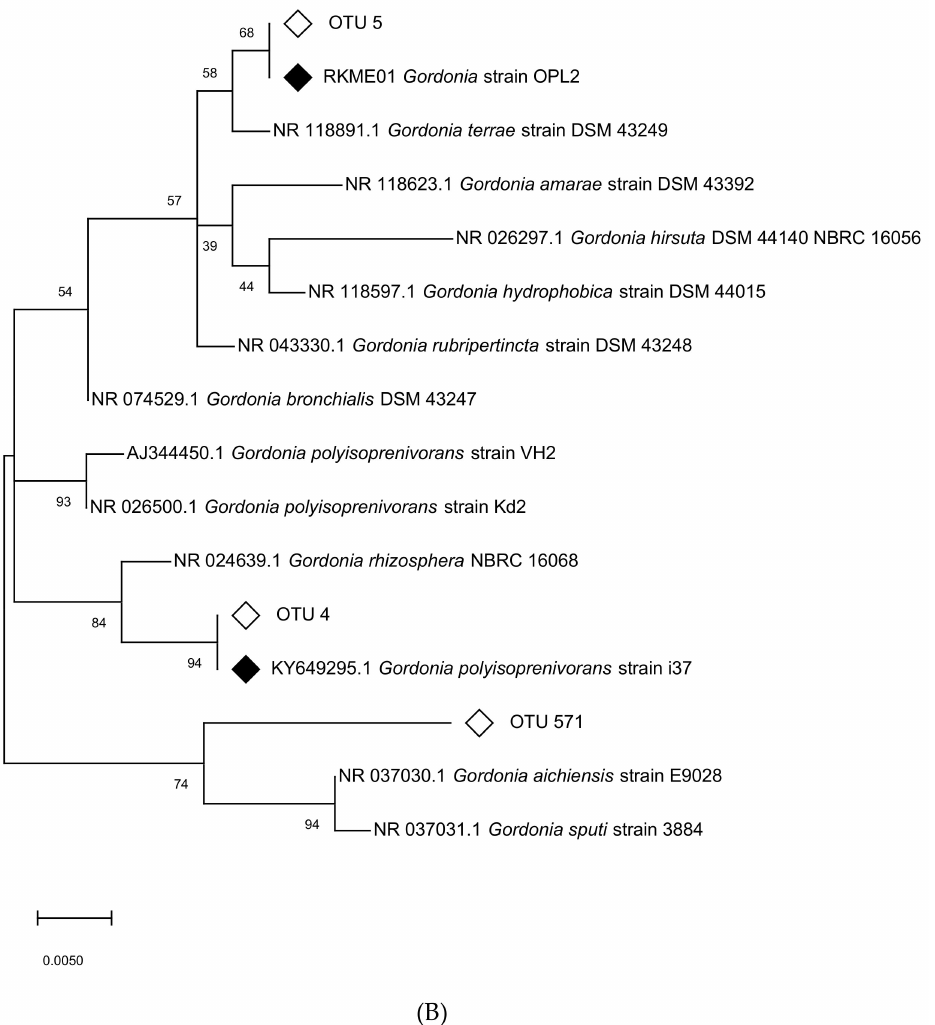
Figure 2. Partial 16S rRNA gene phylogenetic trees showing the oil palm leaf isolates, the most abundant closely related OTUs during DNA-SIP enrichments and related representatives from the databases: Sphingopyxis strain OPL5 (A) and Gordonia strain OPL2 (B).Trees were constructed using the Maximum Likelihood method using the partial 16S rRNA gene (V3 to V4 variable regions) amplified using 341f and 785r primers [1]. Following removal of gaps and missing data, there were 418 bp (A) and 409 bp (B) in the alignment. Bootstrap values (1000 replications) are shown. Strains isolated in this study are indicated with black diamonds and the most abundant closely related OTUs with empty diamonds. Relative abundance (%) of the most abundant OTUs before (T 0 ) and throughout the DNA-SIP experiments (T 1 , T 2 , and T 3 ) for soils and leaf washings were as follows: A) Sphingomonadaceae-like OTU 240 (in soils < 0.6% and on leaves 1.4% at T 0 , 18.7% at T 1 ), OTU 2 (in soils < 0.4% and leaves 7.5% at T 1 ) and OTU 37 (in soils < 0.1% and leaves 1.2% at T 1 ). B) Gordonia -like: OTU 4 (in soils 1.5% at T